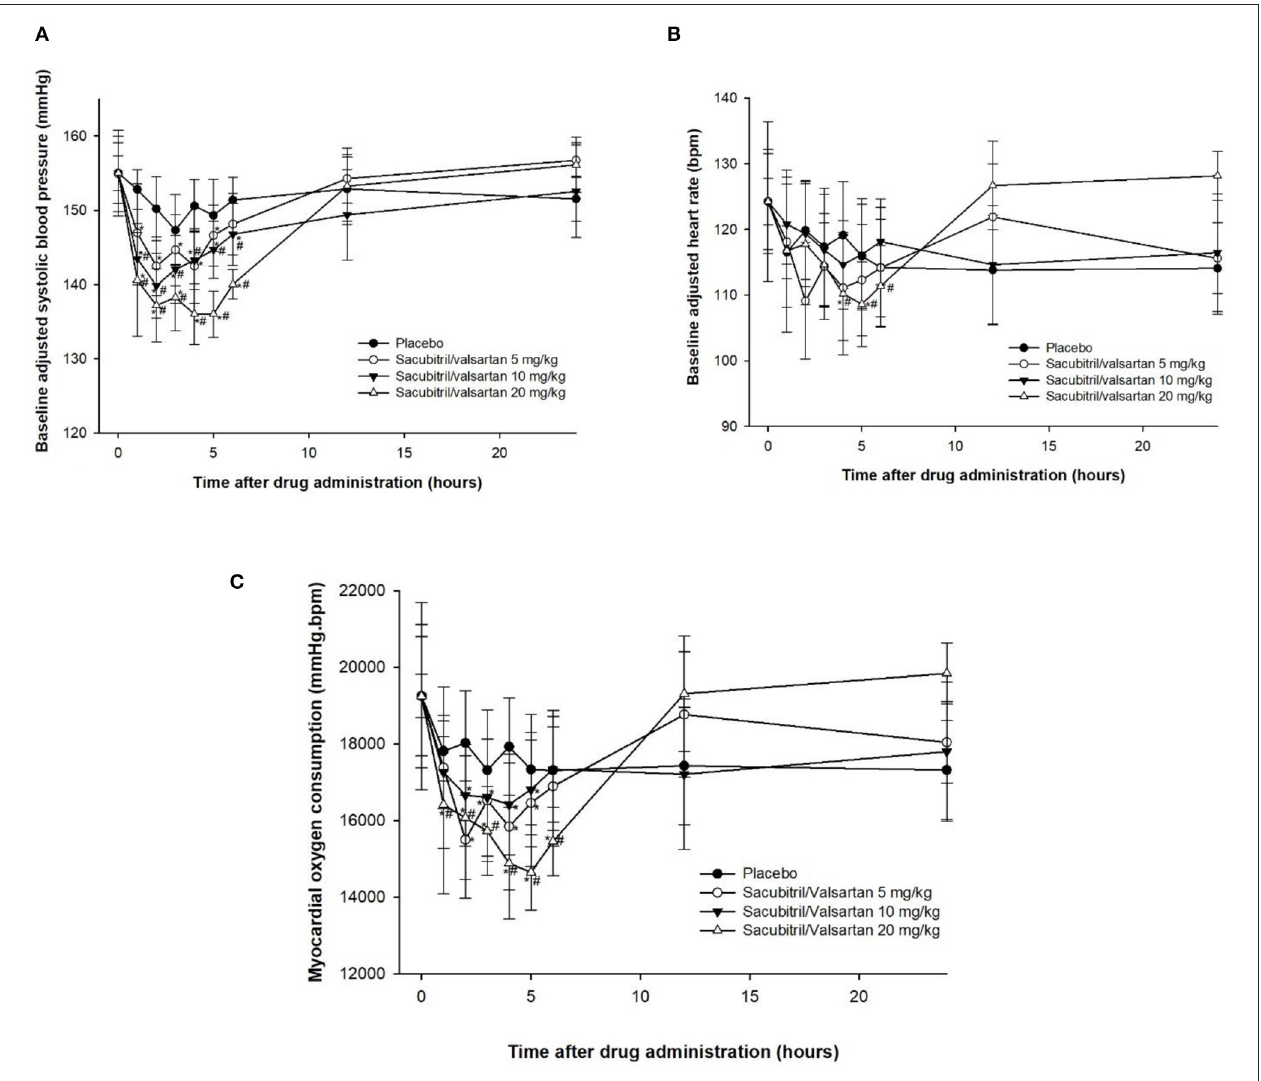
FIGURE 1 | Plots of baseline adjusted systolic blood pressure (A) , heart rate (B) and rate pressure product (C) , an index of myocardial oxygen consumption, against time before (0h) and after administration (1–24h) of placebo and sacubitril/valsartan at a dose of 5, 10, and 20 mg/kg, orally in dogs with asymptomatic mitral valve disease stage B1 ( n = 2) and stage B2 ( n =